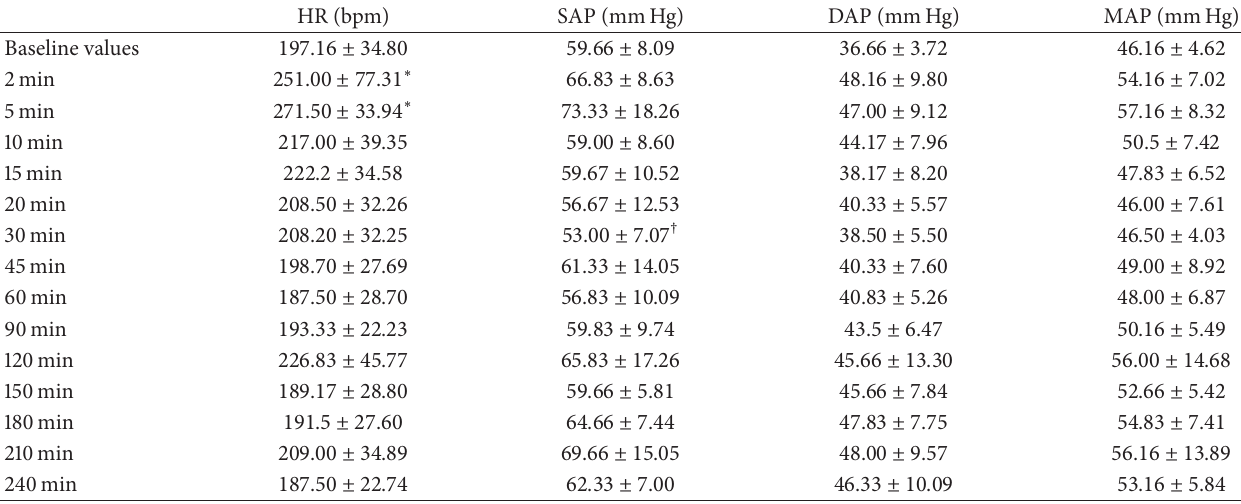
Table 3: Changes in foetal cardiovascular variables following maternal administration of a single intravenous bolus of 2 mg/kg of alfaxalone in a 2-hydroxypropyl- 𝛽 -cyclodextrin formulation (mean ± SD).